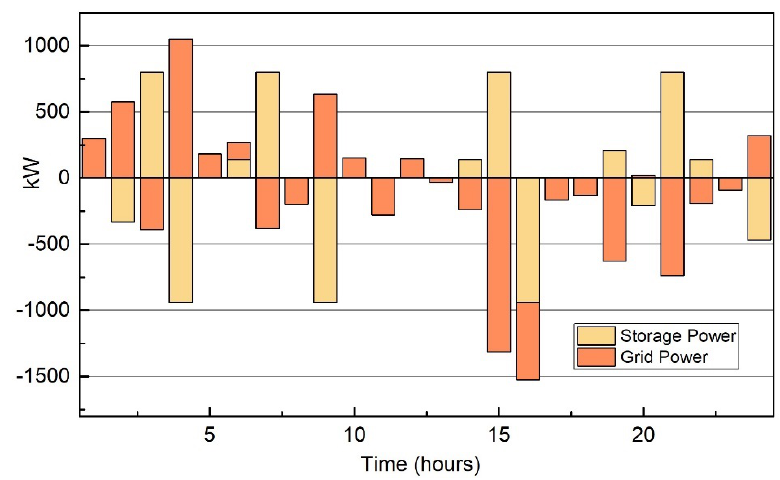
Figure 7. Case (3): Energy exchange with the ESS and grid.